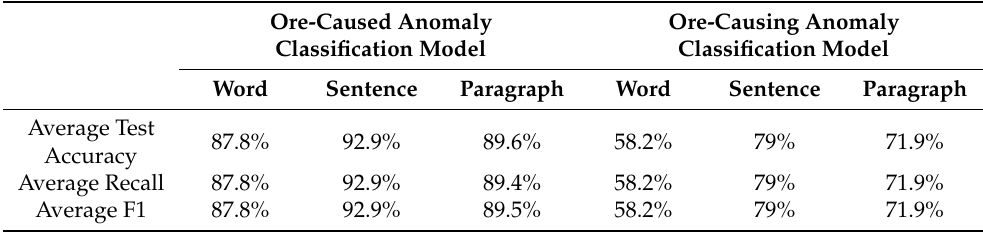
Table 5. Comparison table of average accuracy, recall, and F1 measure of CNN model testing based on multi-scale test